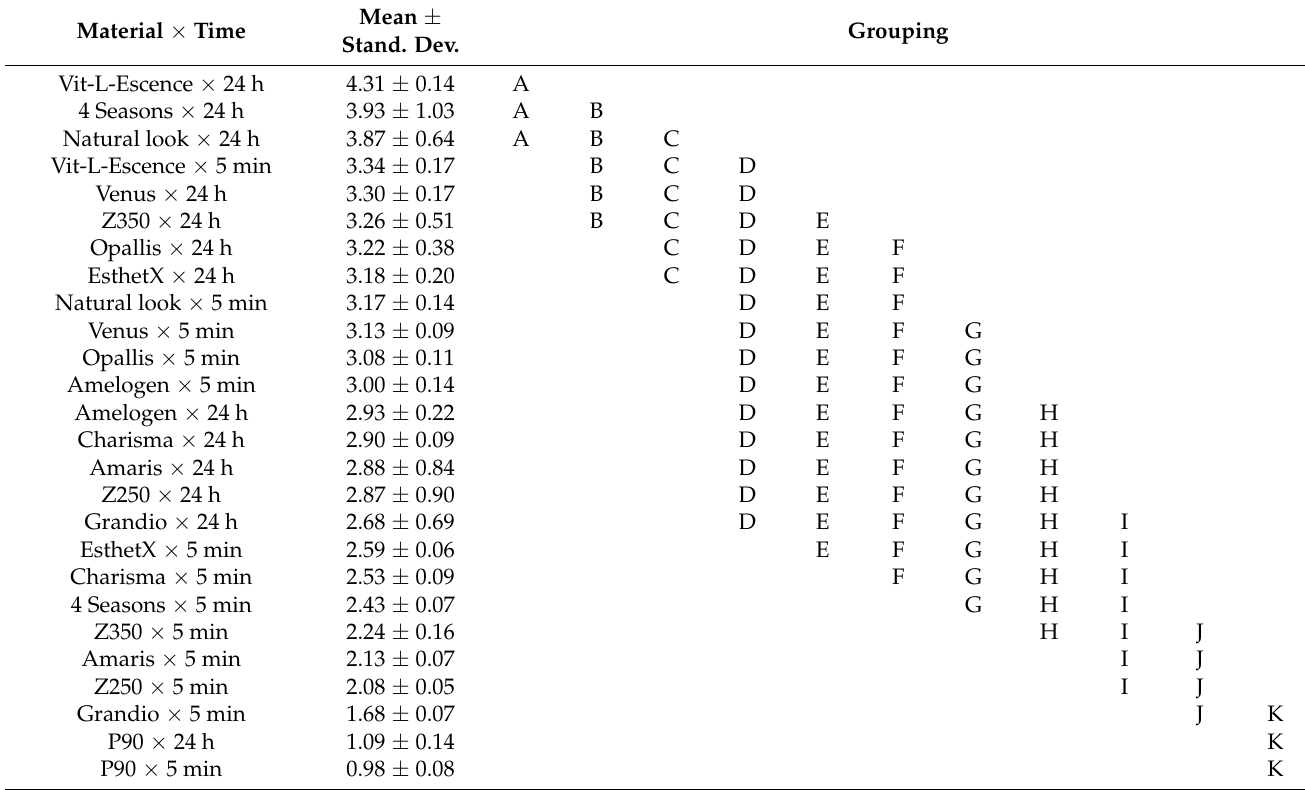
Table 3. Mean and standard deviation for the volumetric shrinkage according to the interaction of both factors, resin composite materials and time. Same Capital Letter(s) means no statistical difference among groups ( α =